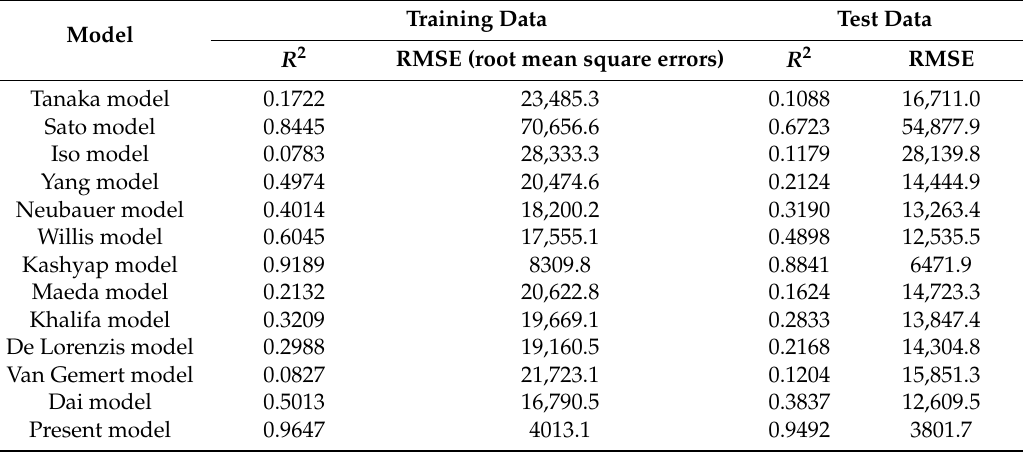
Figure 5. Comparison of GEP model with existing methods in the prediction of the debonding force for the testing data. Table 5. Training and testing results of existing models and